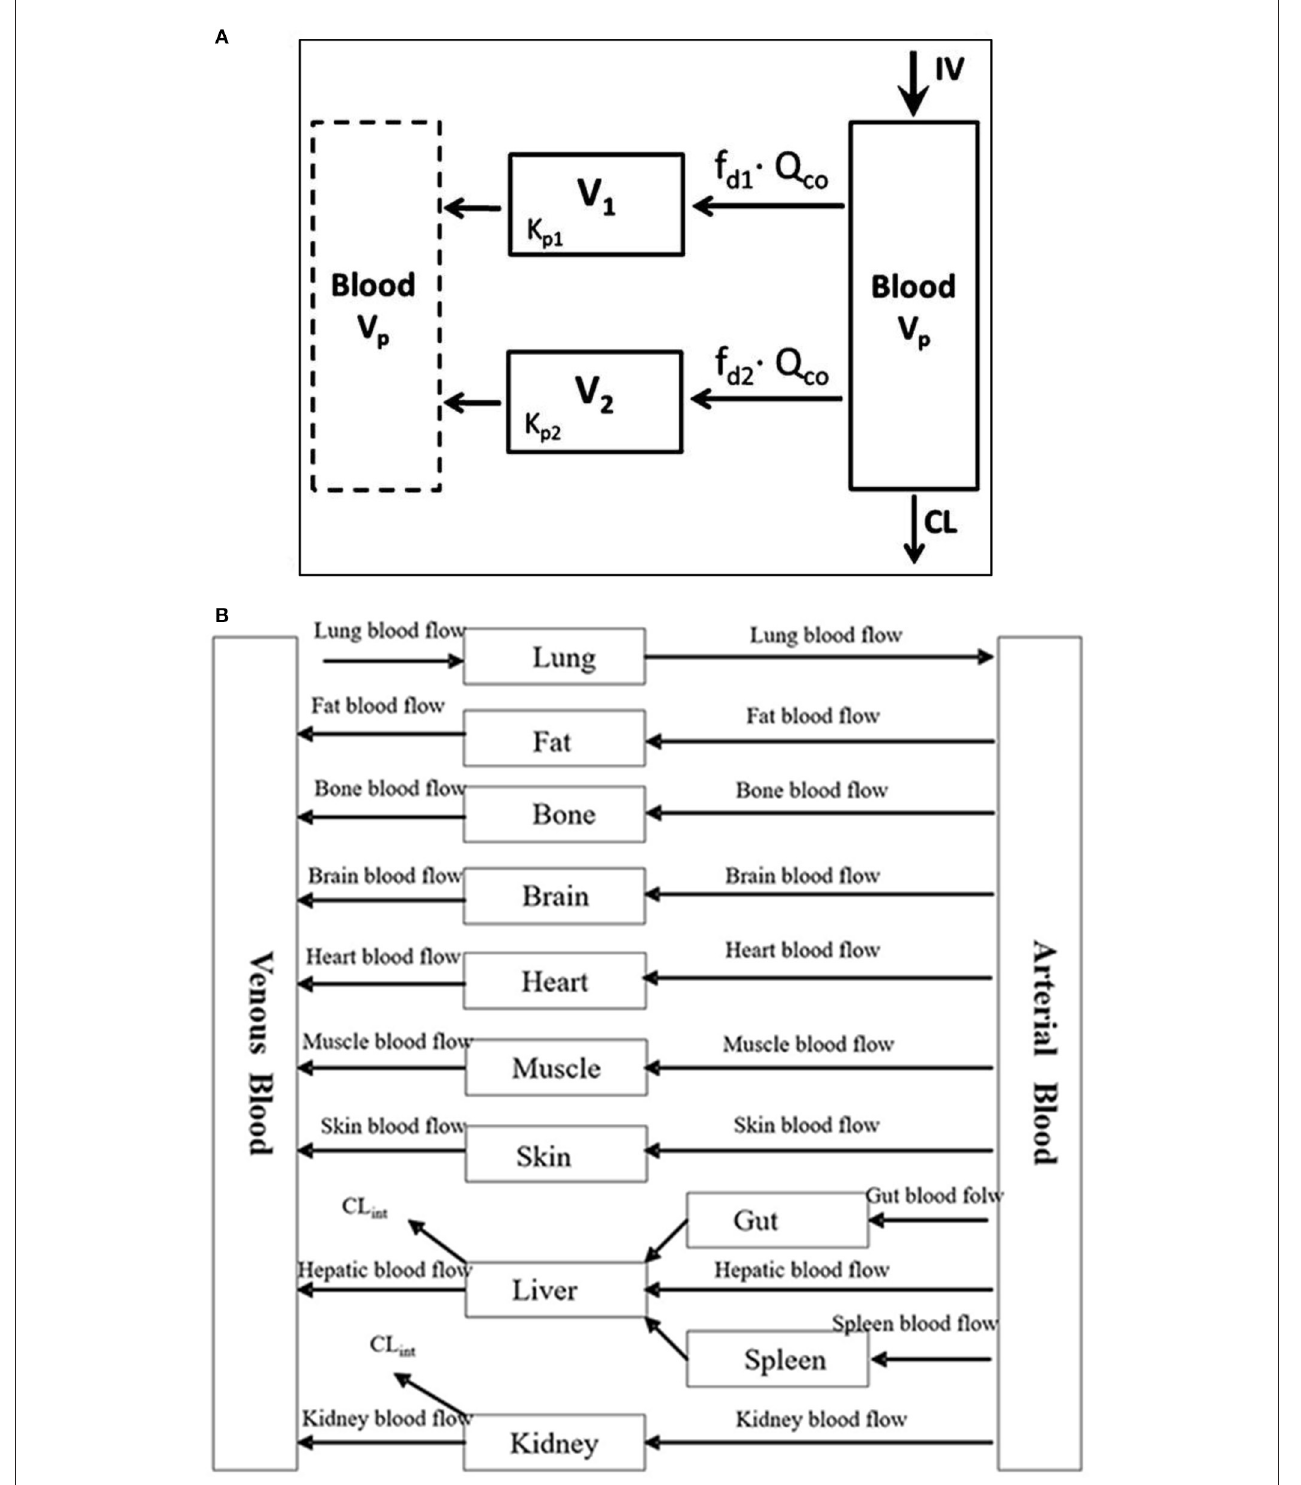
FIGURE 1 | (A) Minimal PBPK model with two tissue compartments (26). (B) Example of a PBPK model (27).